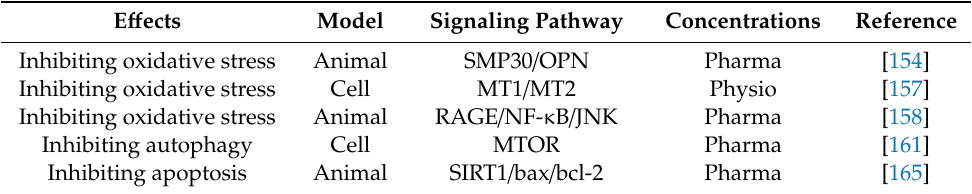
Table 6. Melatonin and vascular